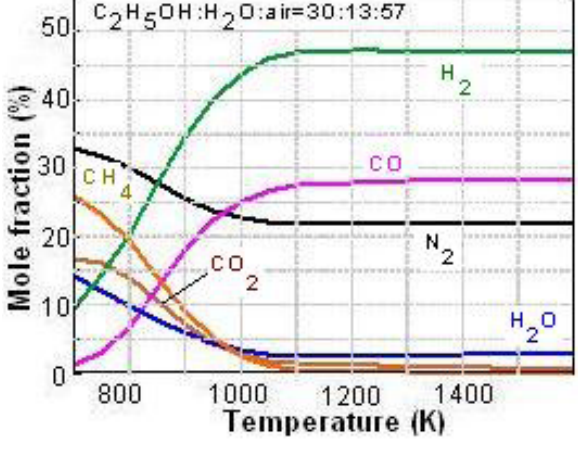
Table 1 : Comparison of experimental and calculated results